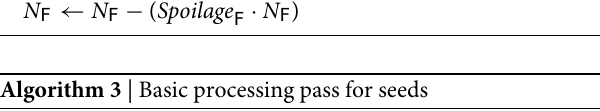
Algorithm 3 | Basic processing pass for